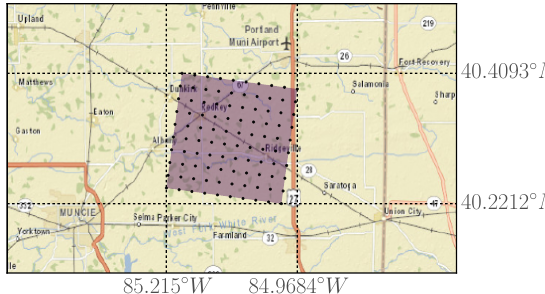
Figure 7. Locations used from the WIND dataset.